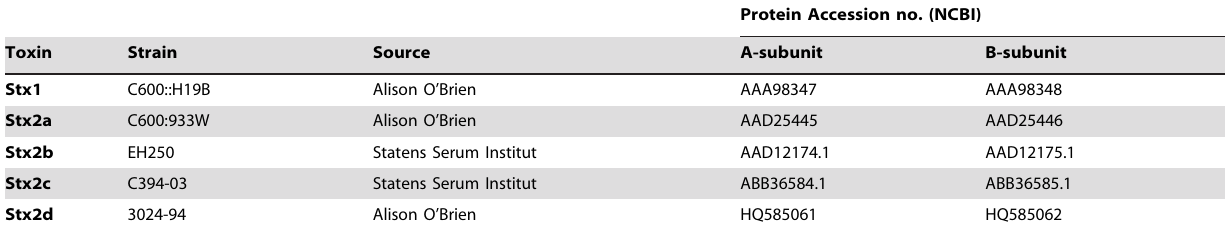
Protein Accession no. (NCBI)